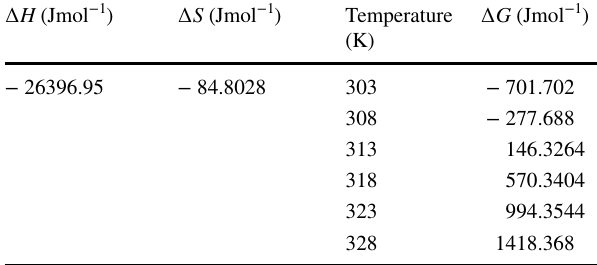
Table 4 Thermodynamic